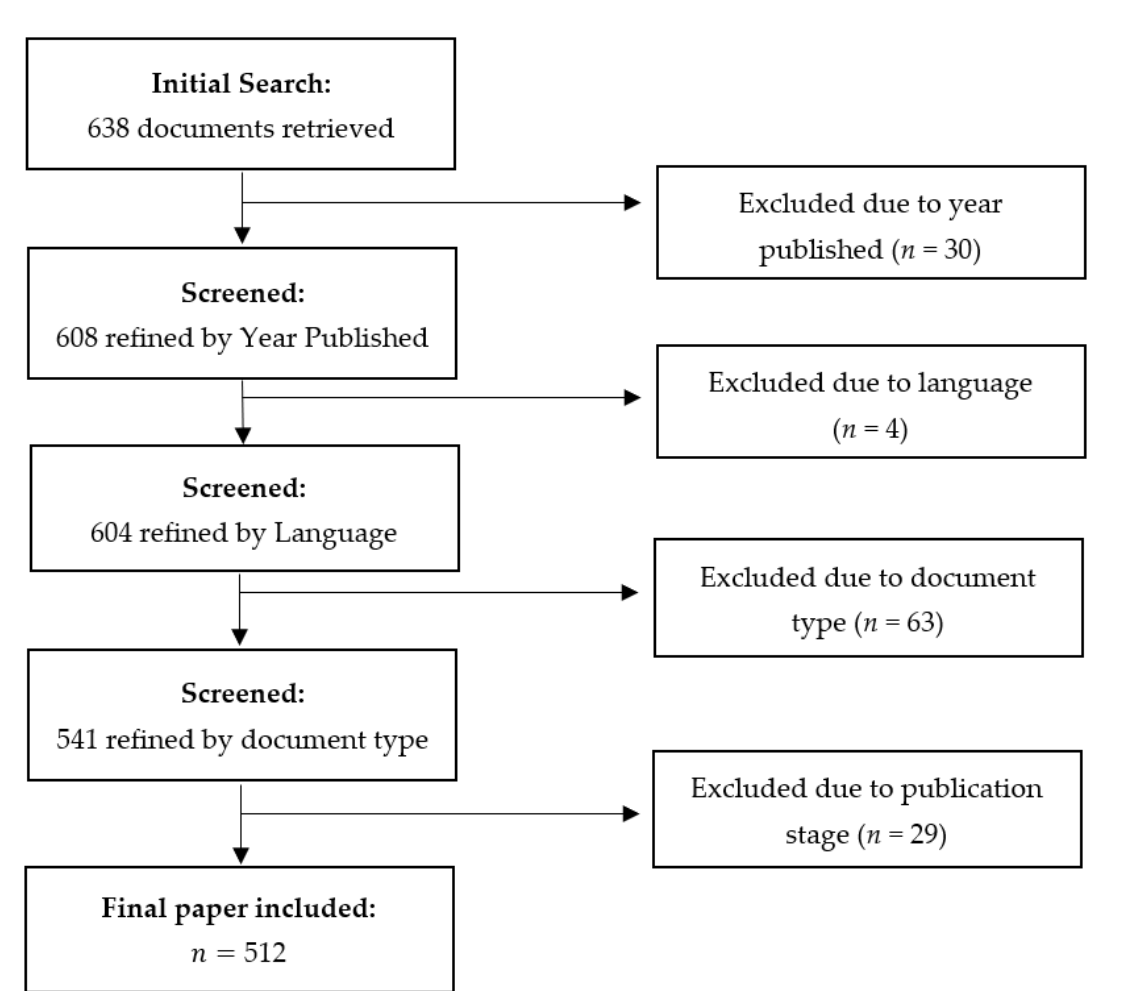
Figure 1. Flowchart of included studies reporting on polymers during the COVID-19 pandemic.